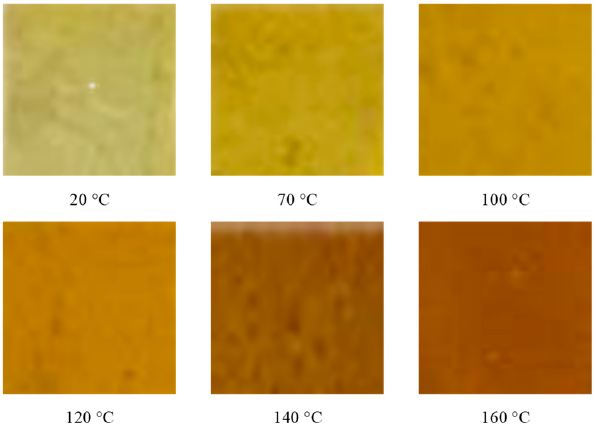
Figure 10. The morphology of HTPE film at different temperatures.